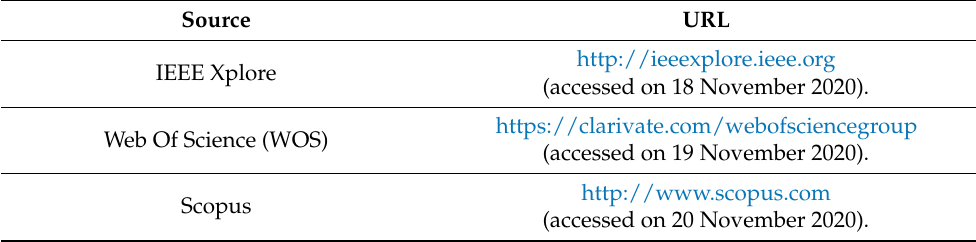
Table 1. Consulted databases.